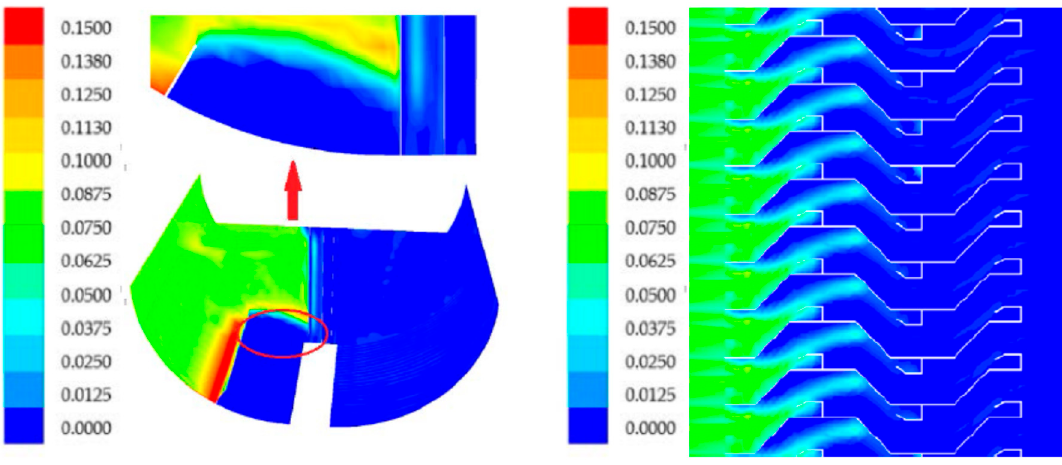
Figure 4. Total pressure distribution in di ff erent section, Pa. ( a ) Longitudinal section. ( b ) Cross section.